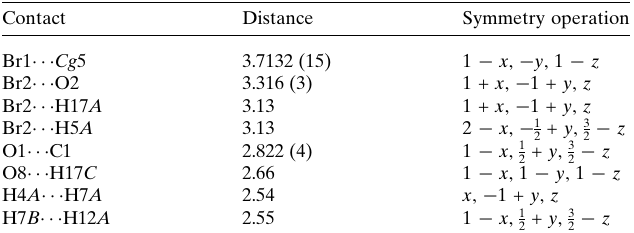
Table 4 Experimental details.